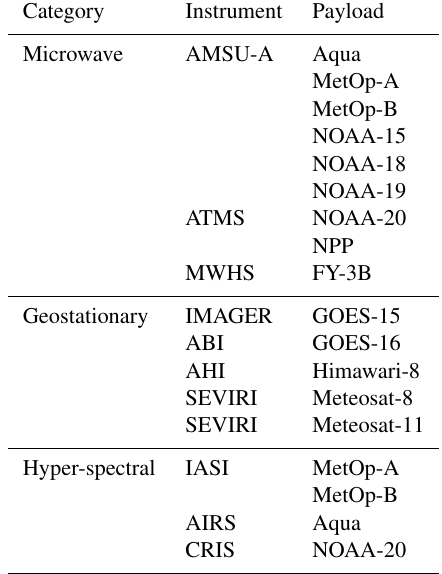
Table 1. The list of instruments used in clear-sky radiance as- similation is as follows: Advanced Microwave Sounding Unit-A (AMSU-A), Advanced Technology Microwave Sounder (ATMS), MicroWave Humidity Sounder (MWHS), Advanced Baseline Im- ager (ABI), Advanced Himawari Imager (AHI), Spinning Enhanced Visible and InfraRed Imager (SEVIRI), Infrared Atmospheric Sounding Interferometer (IASI), Atmospheric Infrared Sounder (AIRS), and Cross-track Infrared Sounder (CRIS). Category Instrument Payload AMSU-A Aqua